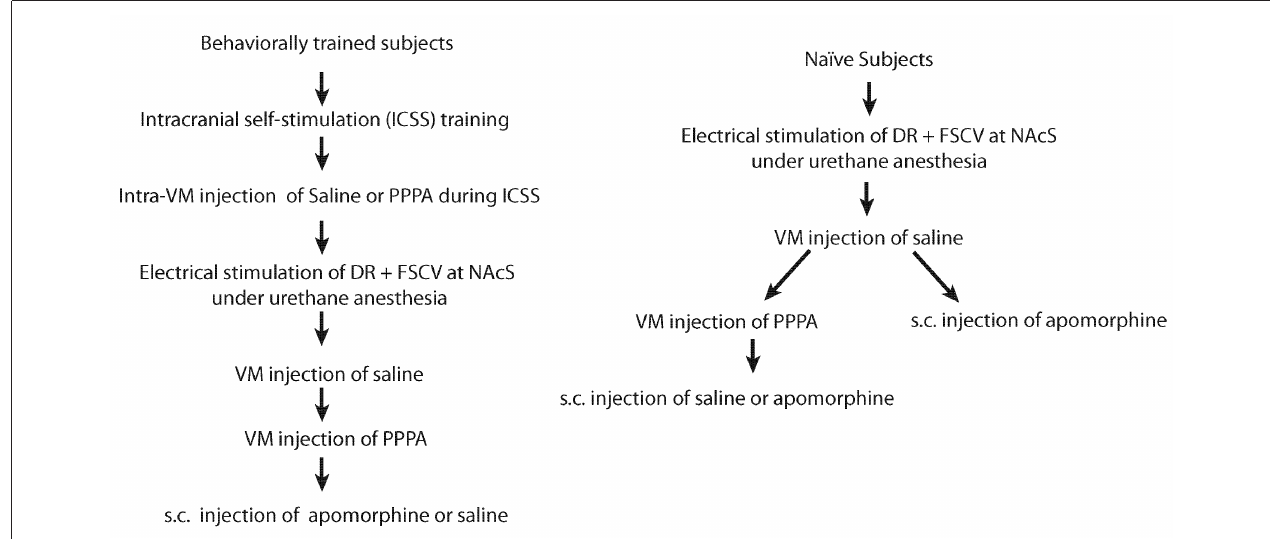
FIGURE 1 | Experimental sequence for behaviorally trained and naïve